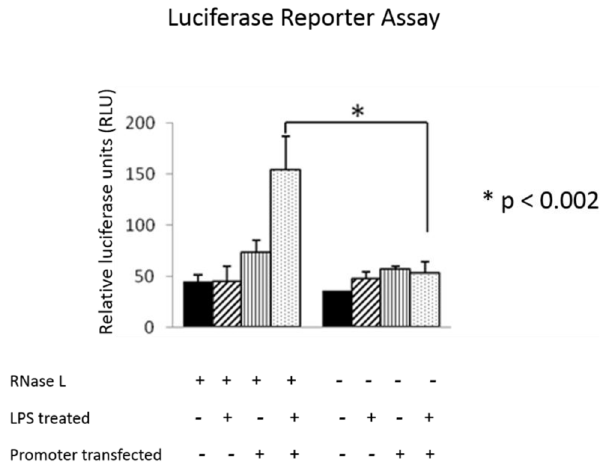
Figure 5. Promoter activity analysis of Cox-2. RNase L deficient and wild type MEFs were transfected with the Cox-2 promoter ( 2 860/ + 127)-pGL3 luciferase reporter construct (20 m g) together with a plasmid containing a b -galactosidase gene (1 m g) by using lipofecta- mine 2000 (Invitrogen, CA) according to the manufacture’s instruction. After transfection, the cells were allowed to recover for 24 h and subsequently treated with or without LPS (1 m g/ml) for 14 h. The activity of luciferase and b -galactosidase was assayed as described in Materials and Methods. The experiments were performed twice in triplicates and the result are present as Mean 6 SD. *p ,